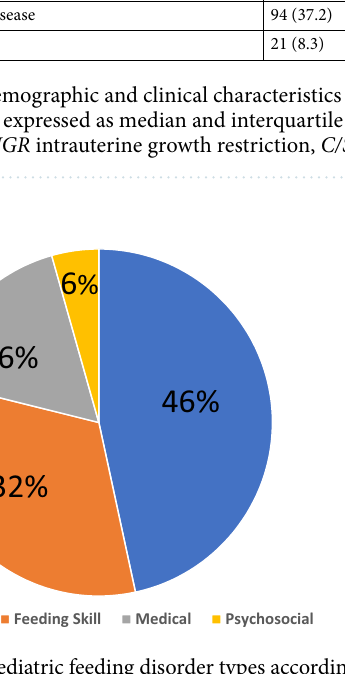
Table 3 lists factors associated with PFD accord- ing to PFD type. There was no difference in sex distribution, gestational age, or rates of multiple pregnancies, preterm deliveries, or IUGR between the study and control groups. There were fewer cesarean section deliveries in the psychosocial PFD group type compared to the 3 other group types. As expected, there were significant dif- ferences in the number of prescribed medications, developmental delays, and prior hospitalizations between the medical PFD group compared to all other groups. Finally, no group differences were noted in the socioeconomic variable (cluster, index, marital status), breastfeeding rates, and age at introduction of complementary foods.